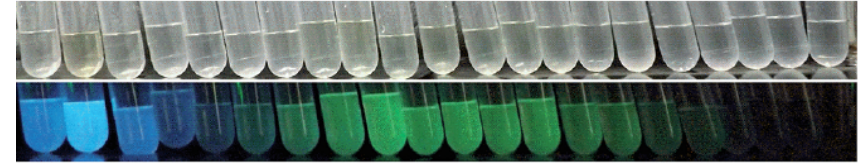
Figure 9. Products from a size exclusion chromatography procedure, as observed under daylight ( top ), or under UV light ( bottom ). Reproduced with permission from [89]. Copyright Royal Society of Chemistry,